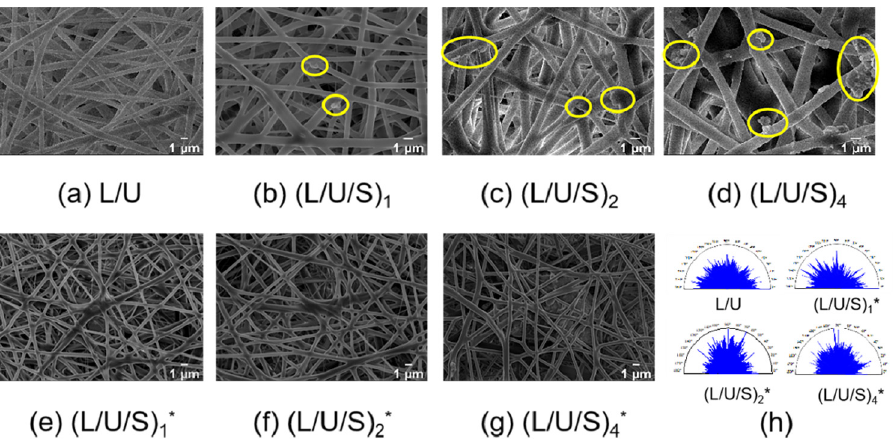
Figure 2. ( a – g ) SEM images of electrospun fibers with different CMCS content before and after cross-linking. ( h ) Polar coordinates of fiber texture direction. CMCS particles are circled by yellow solid line ellipses. (L/U/S) 1* , (L/U/S) 2* , (L/U/S) 4* referred to the sample after (L/U/S) 1 , (L/U/S) 2 , (L/U/S) 4 were cross-linked, respectively.